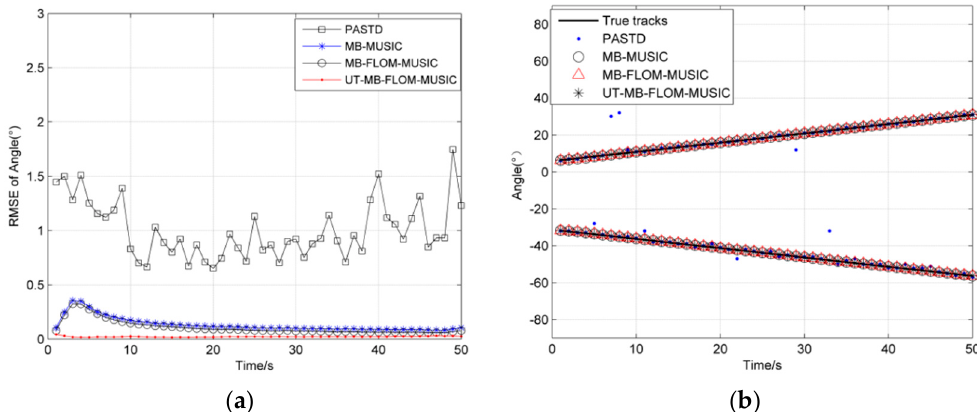
Figure 1. Root mean square error (RMSE) of angle under α = 2, L = 100 and Generalized Signal to Noise Ratio (GSNR) = 10 dB: ( a ) The RMSE of 100 MC; ( b ) source trajectory of Single